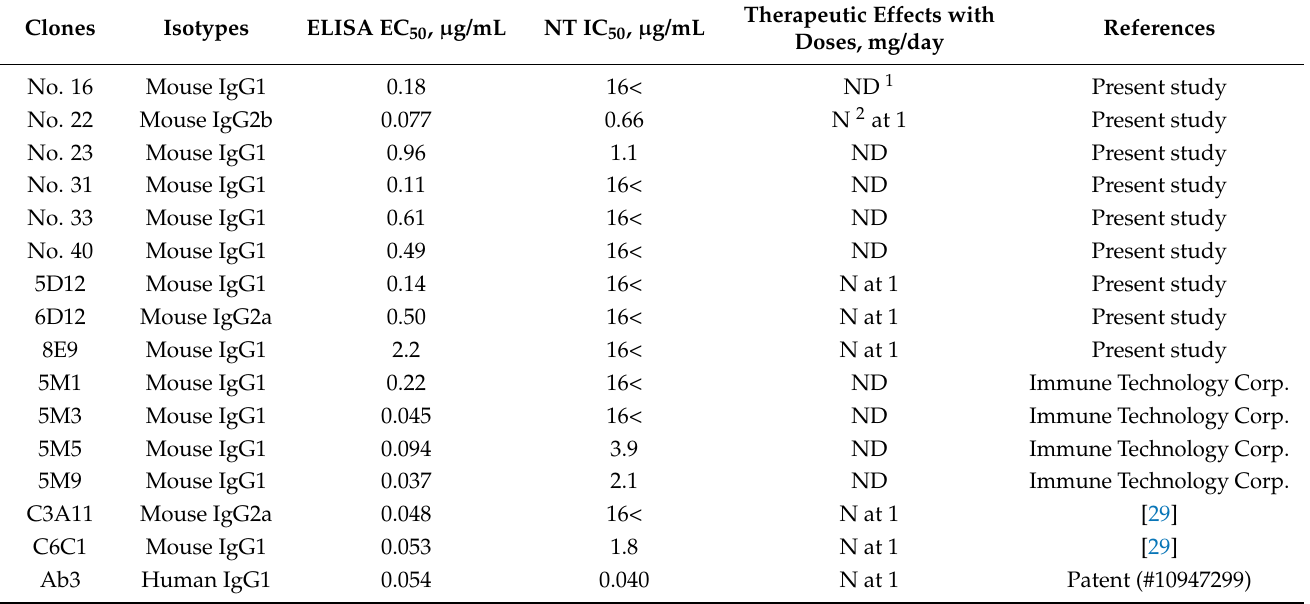
Table 2. mAbs specific to SFTS virus Gc